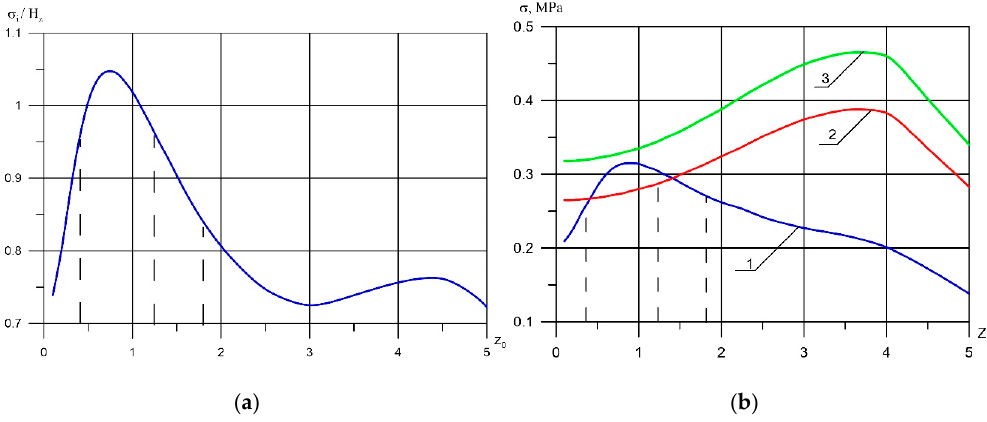
Figure 9. DCS CB-60 sample: ( a ) the amplitude of the ratio of octahedral stresses to hardness; ( b ) current Figure 9. DCS CB ‐ 60 sample: a ) the amplitude of the ratio of octahedral stresses to hardness; b ) current and permissible equivalent stress: (1) σ e equivalent stress; (2) σ Hke min minimum allowable stress and permissible equivalent stress: (1) equivalent stress; (2) minimum allowable stress according to the according to the DCS criterion; (3) σ Hke max maximum allowable stress according to the DCS criterion. DCS criterion; (3) maximum allowable stress according to the DCS criterion. The calculations showed important features of the CD-30 and CB-60